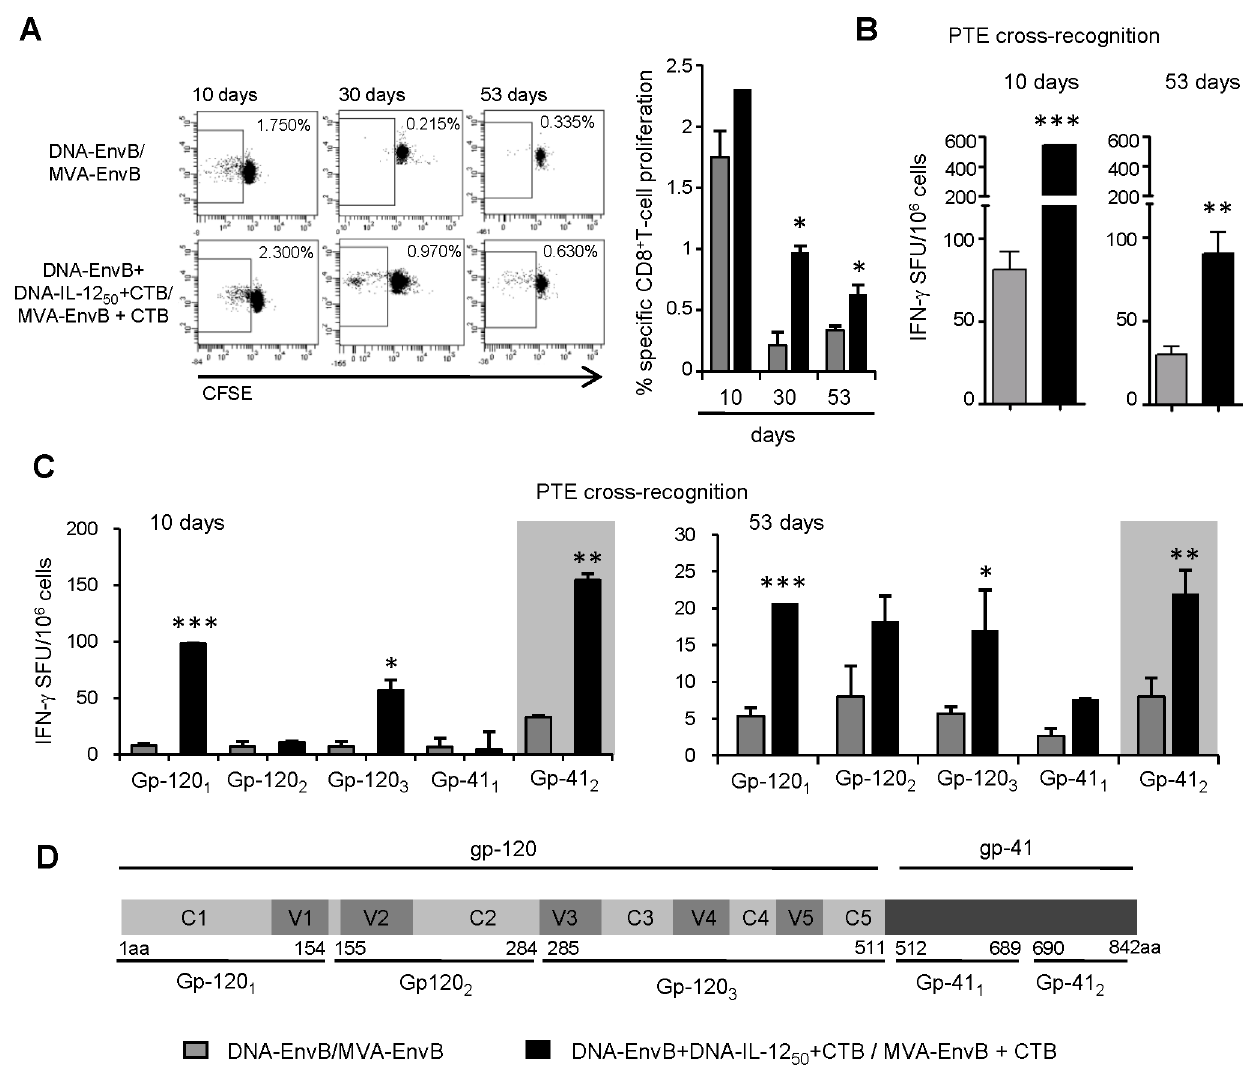
Figure 5. CD8 + T-cell quality measured by its proliferative potential and its ability to recognized cross-reactive peptides. Specific cellular immune responses were analyzed at 10, 30 or 53 days after the immunization in groups of six BALB/c mice. Pooled splenocytes of DNA-EnvB/ MVA-EnvB (grey bars) and DNA-EnvB + DNA-IL-12 50 + CTB/MVA-EnvB + CTB (black bars) groups were evaluated. (A) CFSE-labeled cells were stimulated in vitro during 4 days with the specific V3 loop peptide and then stained with surface antibodies (CD3 and CD8). Proliferating CFSE low CD8 T-cells was determined by flow cytometry. A representative dot plot is depicted (left panel) and percentage of proliferating cells were analyzed (right panel). (B) Ten and 53 days after immunization, splenocytes were stimulated with different pools of Env PTE peptides and evaluated by ELISPOT. Bars represented the accumulated number of IFN- c spot forming units (SFU)/10 6 cells for the total PTE peptide-pools. (C) Magnitude of the response against the individual PTE peptide-pools is depicted. (B) and (C): Data are representative of two independent experiments. Bars represent the average + SD for duplicate samples. Background values were subtracted in each case. Statistical differences between groups: *p , 0.05; **p , 0.01; ***p , 0.001 by Student’s T test. (D) Scheme indicating the gp160 region included in the different PTE peptide pools. peptide set, in which a total of 480 peptides representing A, B, C and non-ABC HIV-1 gp160 subtypes were included. In this case, the peptide set was divided into five pools: Gp120 1 (aa 1 to 154) including the first constant (C) and variable (V) structural domains of the protein (C1 and V1), Gp120 2 (aa 155 to 284) including V2 and C2, Gp120 3 (aa 285 to 511) spanning from V3 to C5